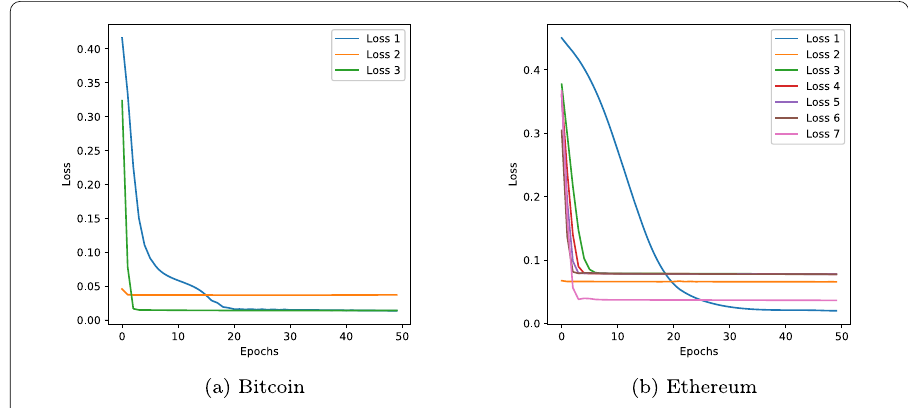
Figure 2 RNN Loss against number of epochs. Panel (a) RNN trained with Bitcoin only data (1) first and then sequentially adding sentiment (2) and sadness (3). Panel (b) RNN trained with Ethereum returns data only (1), then adding sequentially sentiment (2), anger (3), arousal (4), valence (5), dominance (6), love